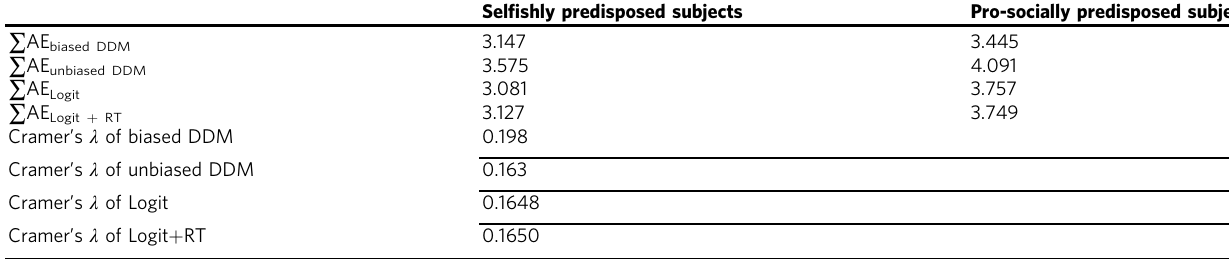
Table 2 Out-of-sample prediction results Sel fi shly predisposed subjects Pro-socially predisposed